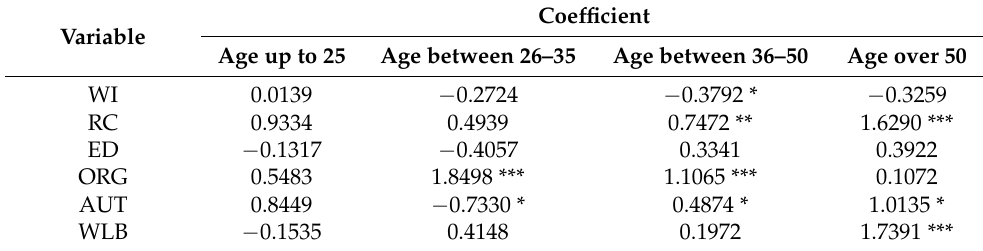
Table 7. Results of the regression—model 3 OLM.